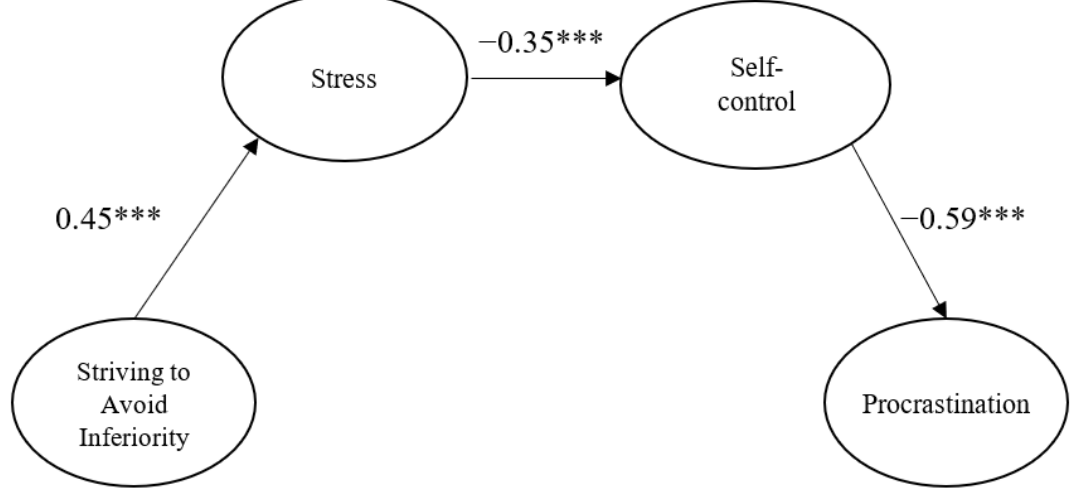
Figure 2. Standardized coefficients for the final model. Measurement errors and parceled indicators are omitted for clarity. *** p < 0.001.